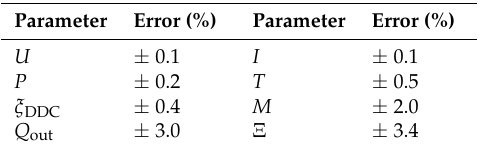
Table 2. Errors of the measured parameters.